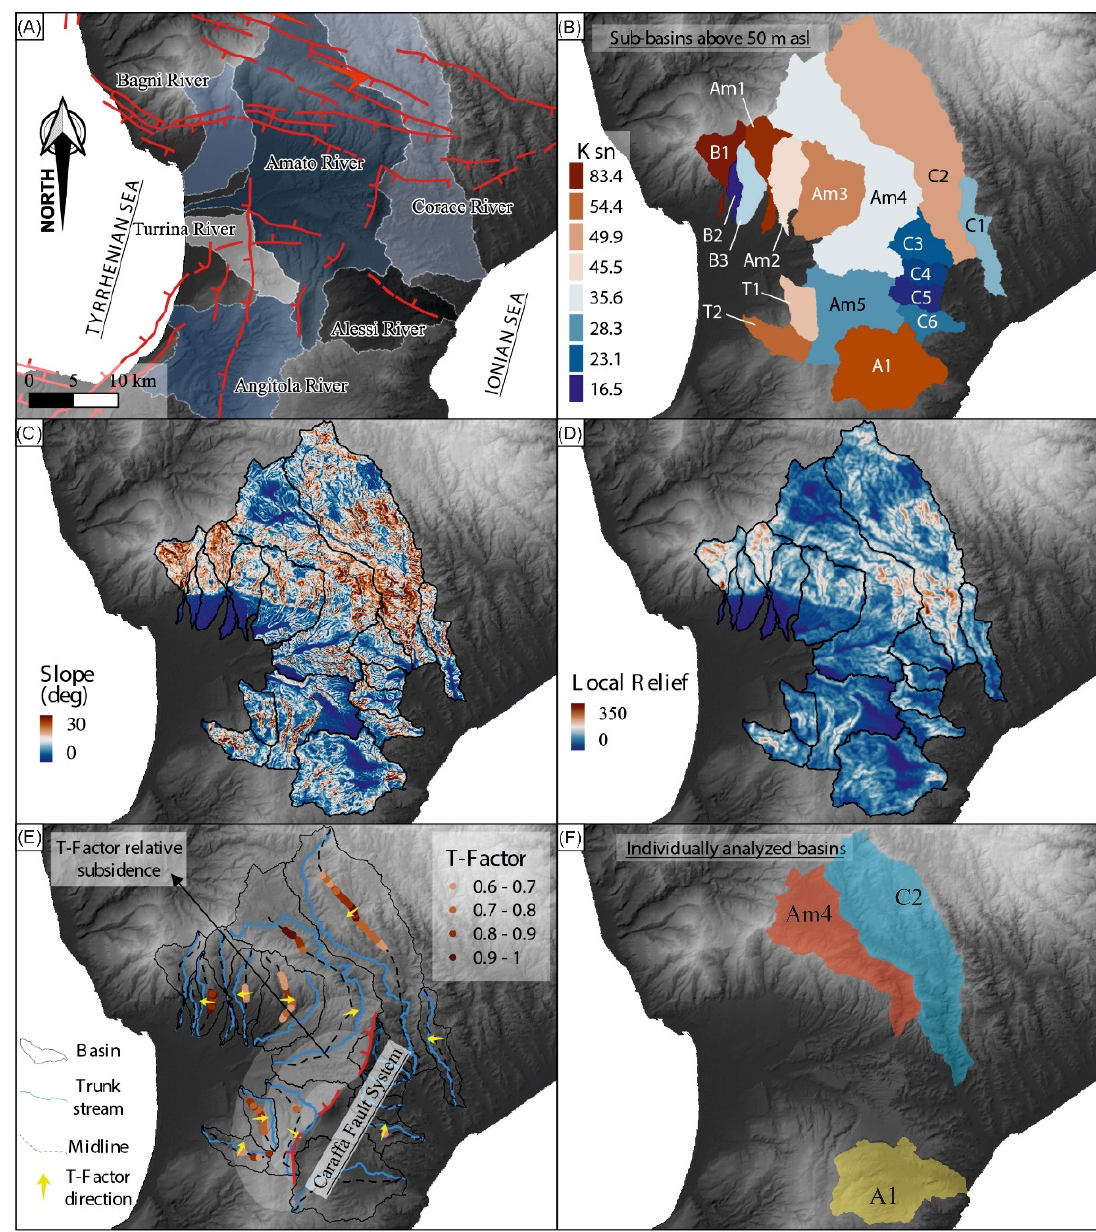
Figure 6. ( A ) Hillshade visualization of the Digital Elevation Model (DEM) of the analysed river basins considered for the analysis. ( B ) B1-3, sub-basins of the Bagni River; Am1-5, sub-basins of the Amato River; C1-6, sub-basins of the Corace River; T1-2, sub-basins of the Turrina River; A1, sub-basin of the Alessi River. Ksn values of each sub-basin. ( C ) Slope analysis; values are in degrees. ( D ) Local relief trend. ( E ) T-factor represented by coloured bars; yellow arrows indicate the direction of migration of the main river trunk. ( F ) Sub-basins further analysed through the morphometric approach.